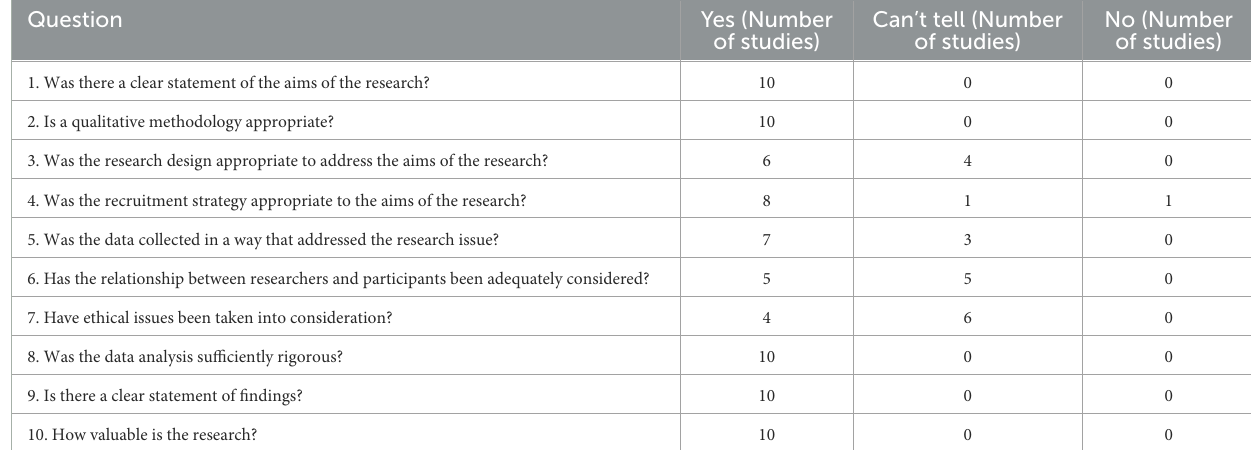
TABLE 2 Evaluations of methodological quality of the studies—CASP checklist. Question Yes (Number